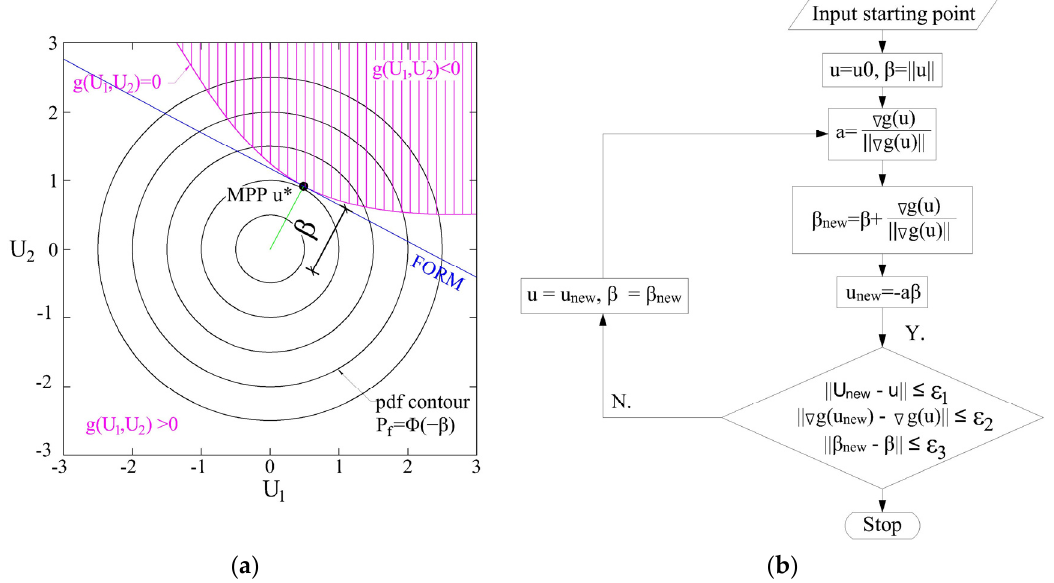
Figure 4. ( a ) Geometrical representation of the reliability index in First Order Reliability Method (FORM); ( b ) The iterative procedure for reliability index calculation using FORM [32].